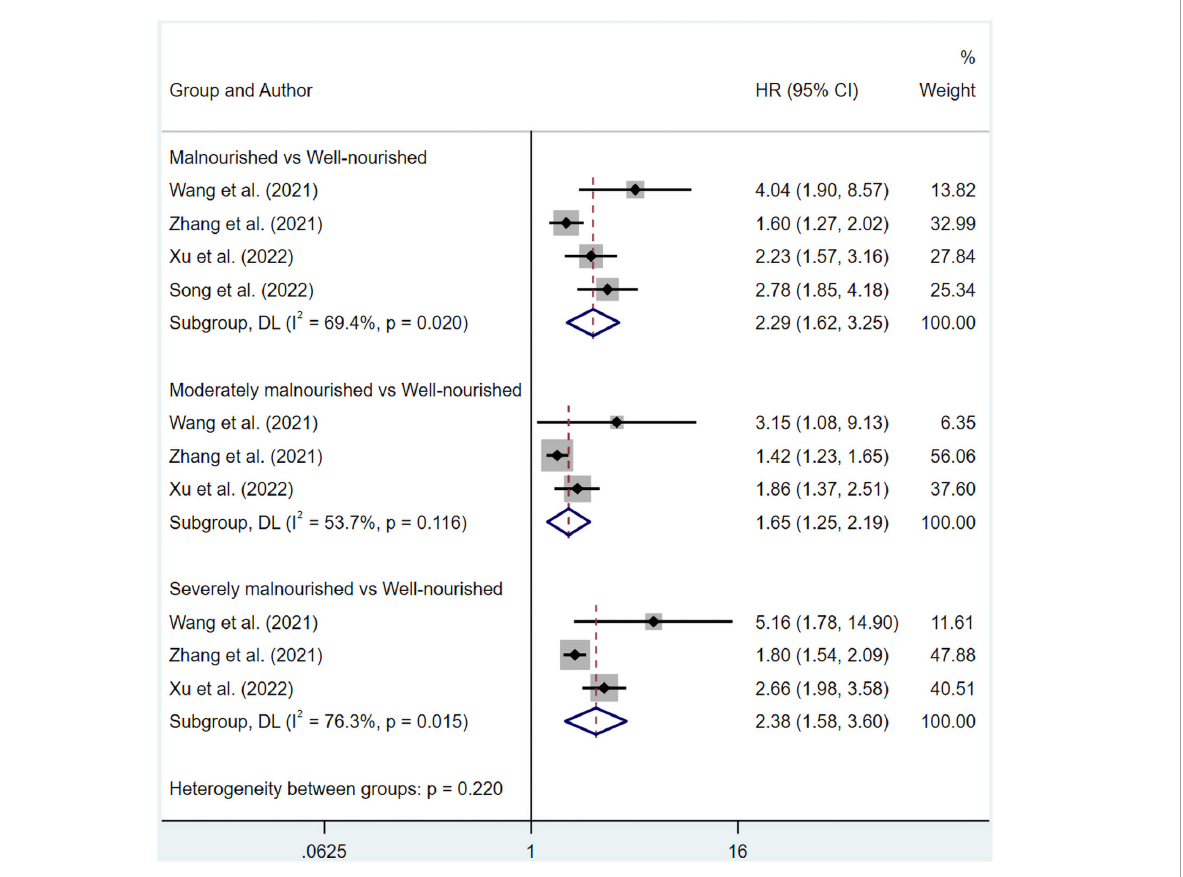
FIGURE3 Forest plots showing pooled HR with 95% CI of overall survival under univariate regression model. X-axis indicated hazard ratio (HR). Weights and between-subgroup heterogeneity test are from random-effects model.